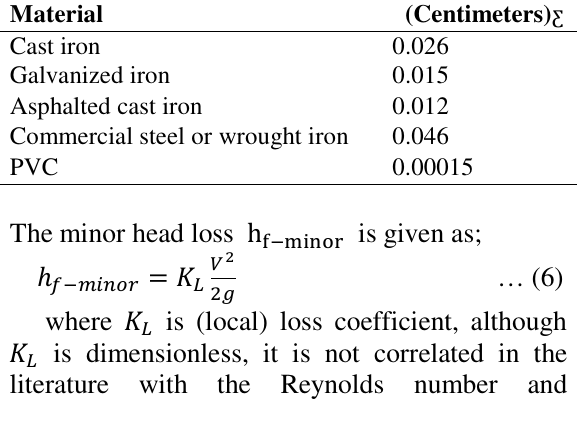
Flow coefficient (